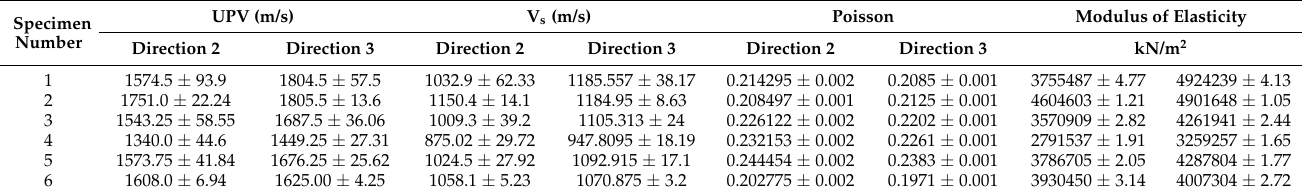
Table 1. Test results of Bitlis